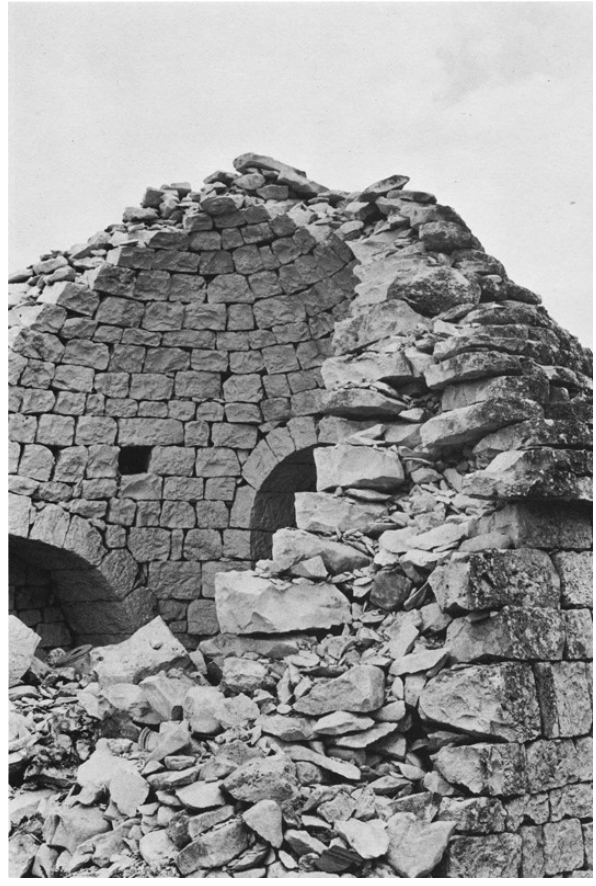
Figure 1: Example of the partial collapse of a Trullo vault